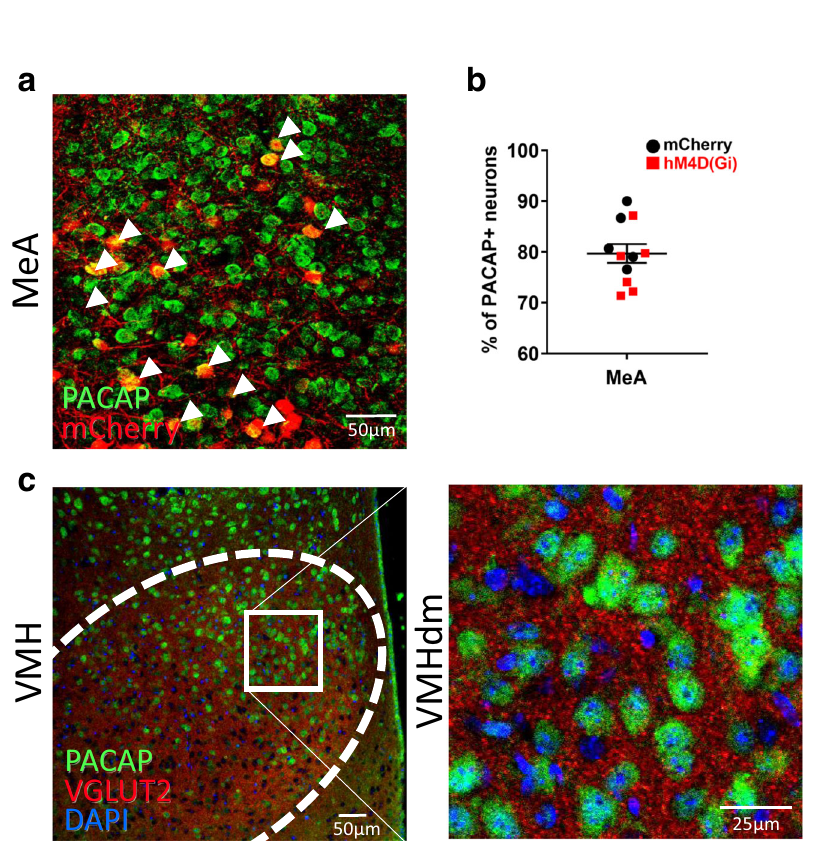
Fig. 5 Sites of delivery of viral vectors in MeA and VMHdm. a Representative image showing the colocalization of mCherry + neurons with PACAP + immunolabeling in the MeA. White arrowheads signal colocalization. b Quanti fi cation of the proportion of mCherry + cells with PACAP + immunolabeling of animals receiving AAV5rg-pmSyn-EBFP-Cre in the VMHdm and either AAV-hM4Di-DREADD or AAV-DIO-mCherry in the MeA (mCherry: n = 5, hM4D(Gi): n = 6). c Representative image showing a prominent VGLUT2 expression in the VMHdm where PACAP + neurons are enriched. Data are expressed as mean ± SEM. Scale bars a , 50 μ m; c left panel scale bar 50 μ m, right panel 25 μ m. MeA medial amygdala, VMHdm ventromedial hypothalamus dorsomedial nucleus. Source data are provided as a Source Data fi